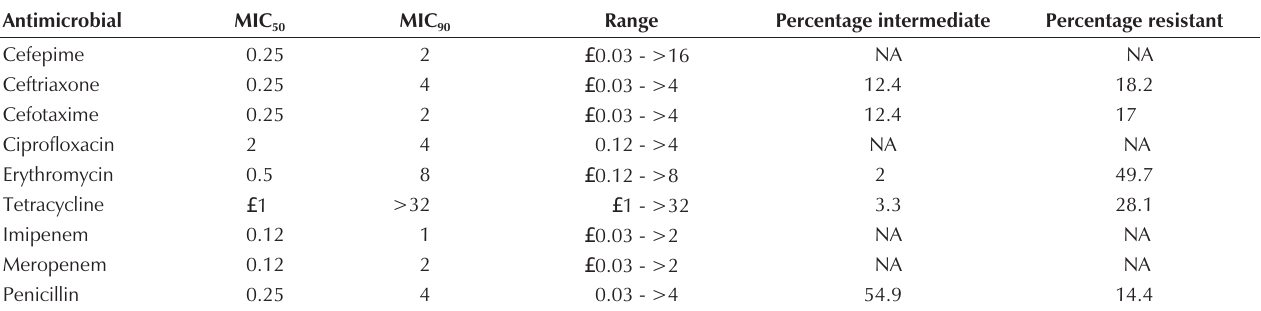
NA Category breakpoints not available